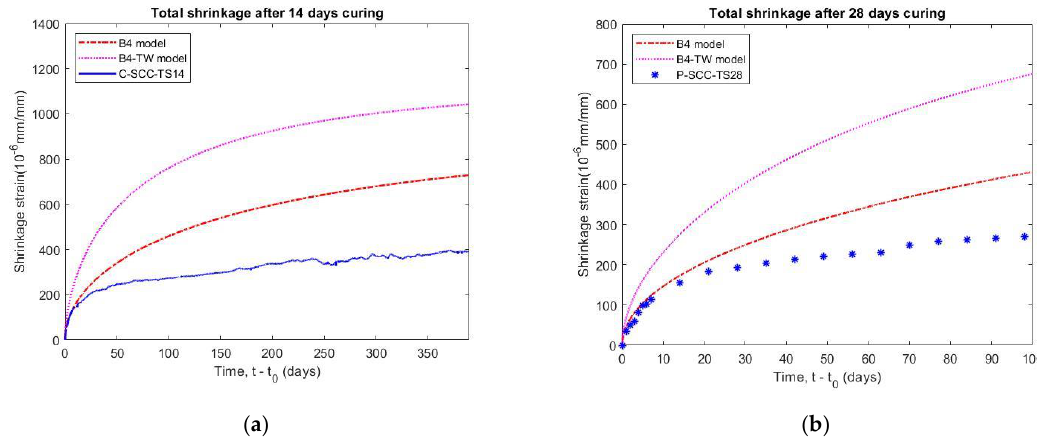
Figure 15. Comparison of measured total shrinkage of SCC with prediction models B4, B4-TW: ( a ) cylindrical specimen